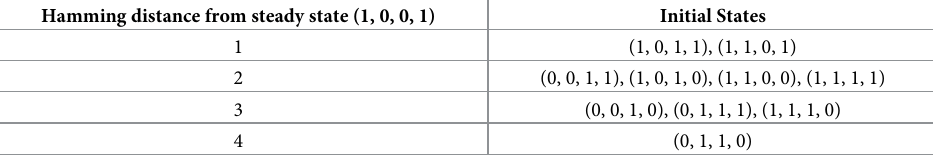
Table 2. Sorting of the initial states according to their Hamming distance from the steady state (1, 0, 0, 1). Hamming distance from steady state (1, 0, 0, 1)